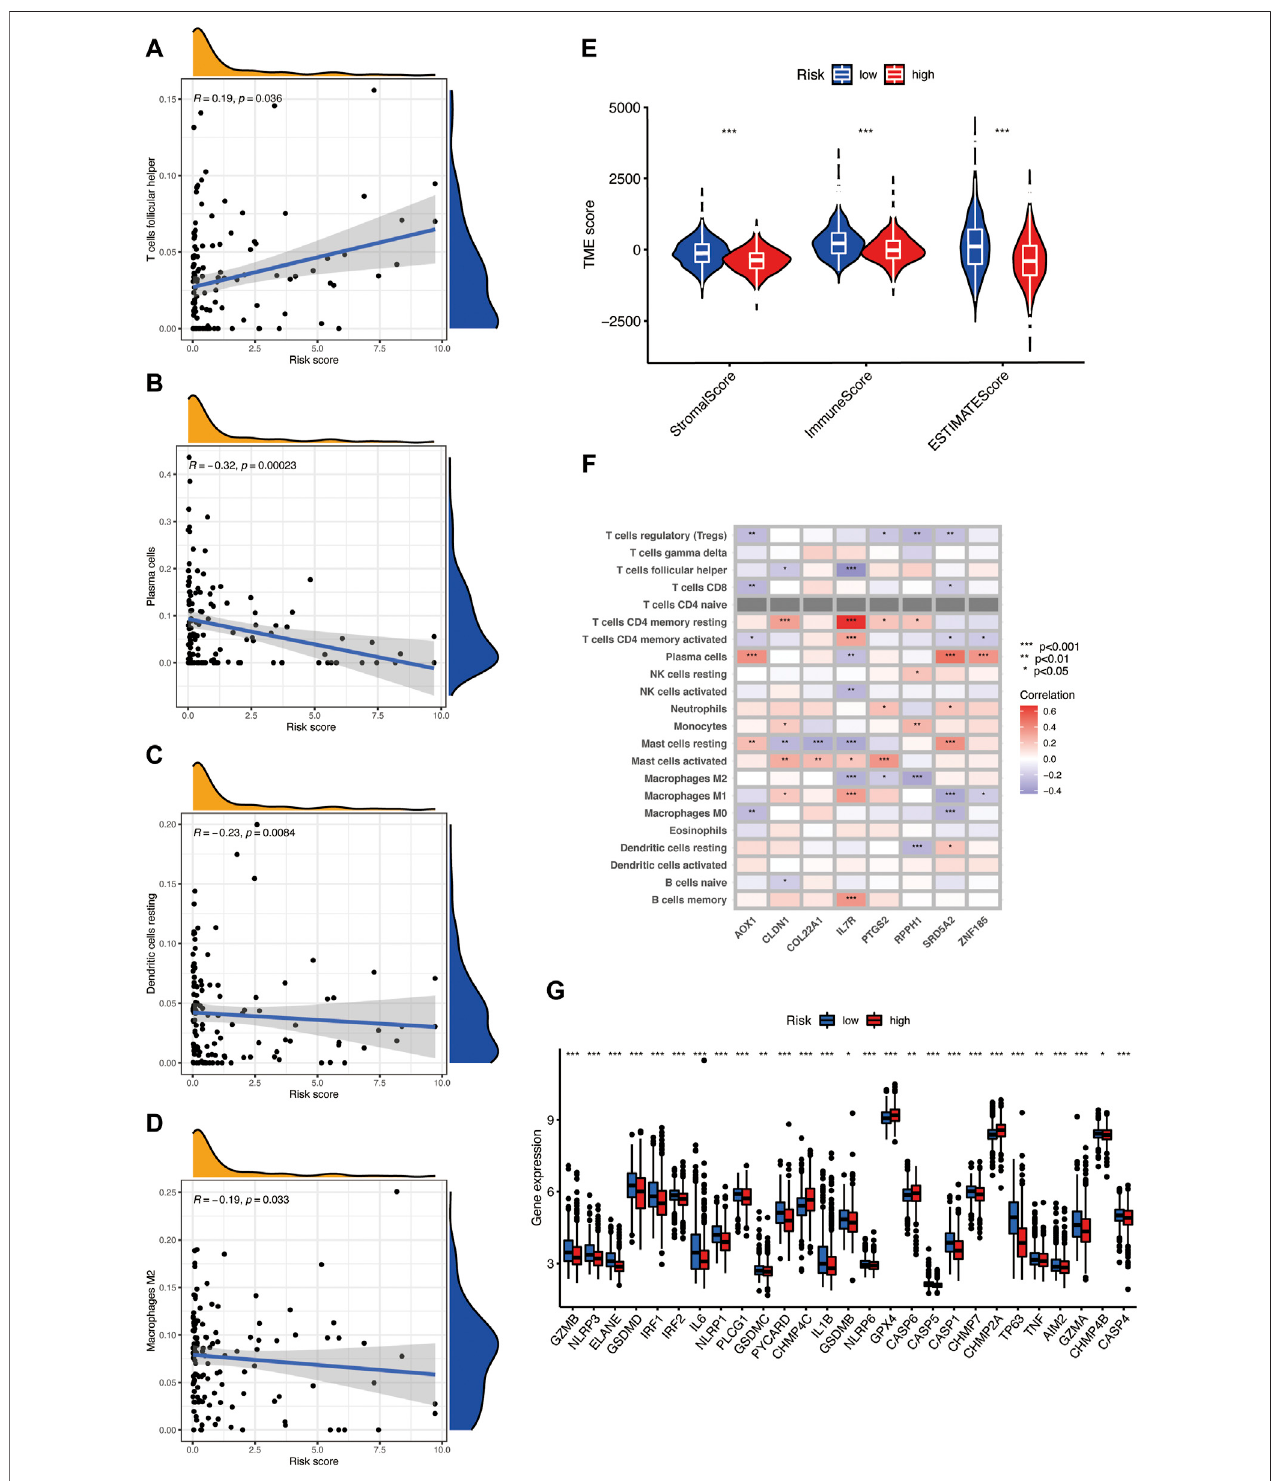
FIGURE7|(A – D) TheriskscorehasapositivecorrelationwiththeT-cellfollicularhelperandanegativecorrelationwithdendriticcellresting,macrophagesM2,and plasma cells, as found using the CIBERSORT algorithm. (E) TME scores in the two risks groups, including the stromal score, immune score, and ESTIMATE score. (F) The relationship between eight selected PRGs and the abundance of immune cells. (G) The expression level of pyroptosis-related genes in two risk groups.